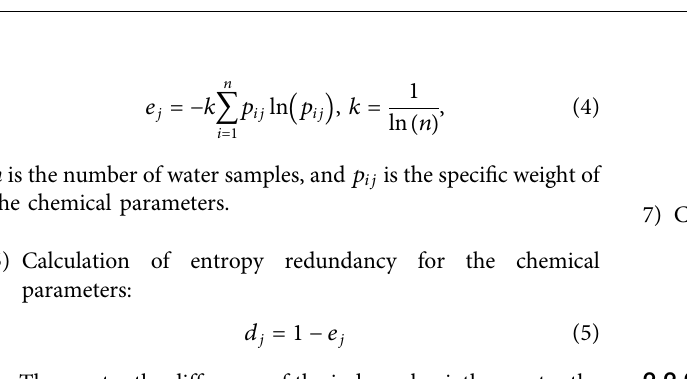
FIGURE2 | (A) Land-use map of the Pinggu District, and A-A ′ is thelocation ofthe geological pro fi le; (B) The geological pro fi le ofthe Pingu area, and the position is shown in Figure 2A (AA ′ ).